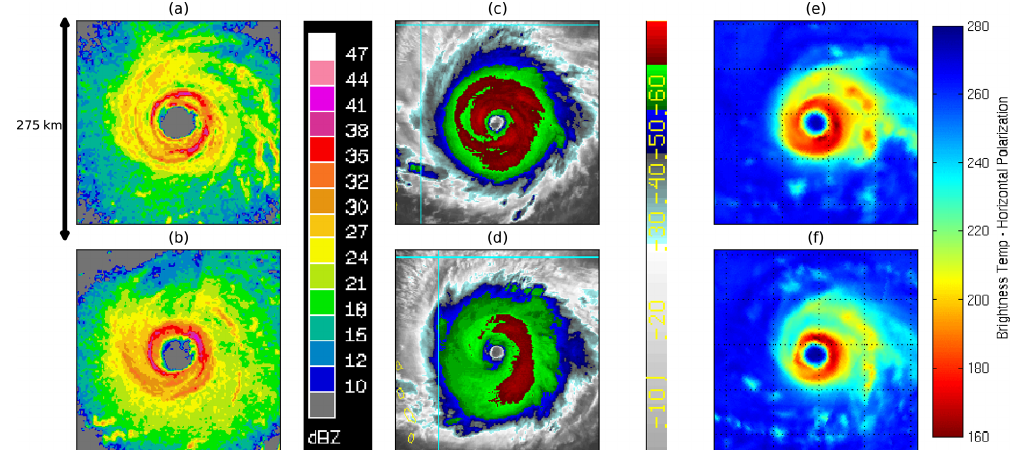
Figure 3. NOAA P3 flight-level radar (in dBZ) on (a) 5 September 09:43UTC and (b) 5 September 12:32UTC, colour enhanced infrared (IR) imagery (in ◦ C) on (c) 5 September 09:45UTC and (d) 5 September 12:45UTC, and MIMIC microwave imagery (brightness temperature in K) for (e) 5 September 09:45UTC and (f) 5 September 12:45UTC. The upper and lower rows correspond to times just before and after the start of the period indicated by the second blue bar in Fig.